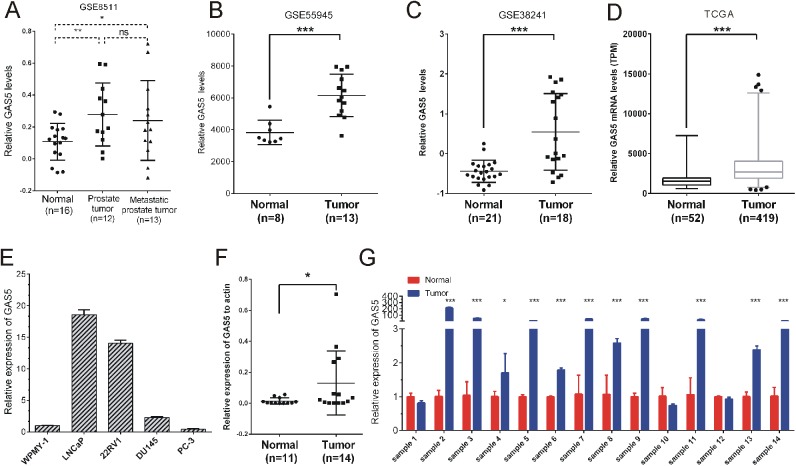
The expression of GAS5 in prostate cancer.(A) The relative expression level of GAS5 in tumor tissue compared with normal tissue in public gene expression data GSE8511, GSE55945 (B) and GSE38241 (C). (D) The relative mRNA level of GAS5 in 52 normal tissue samples compared with 419 tumor tissue samples from TCGA database. (E) Relative expression level of GAS5 was measured in normal prostate epithelial cell line WPMY-1 and four prostate cancer cell lines, LNCaP, 22RV1, DU145 and PC-3 by qRT-PCR. (F) The relative expression of GAS5 in 11 normal prostate tissues and 14 prostate tumor tissues were measured by qRT-PCR. Statistical analyses between groups were performed using an ANOVA analysis. Significance was defined as p < 0.05 (*, p < 0.05; **, p < 0.01; ***, p < 0.001).